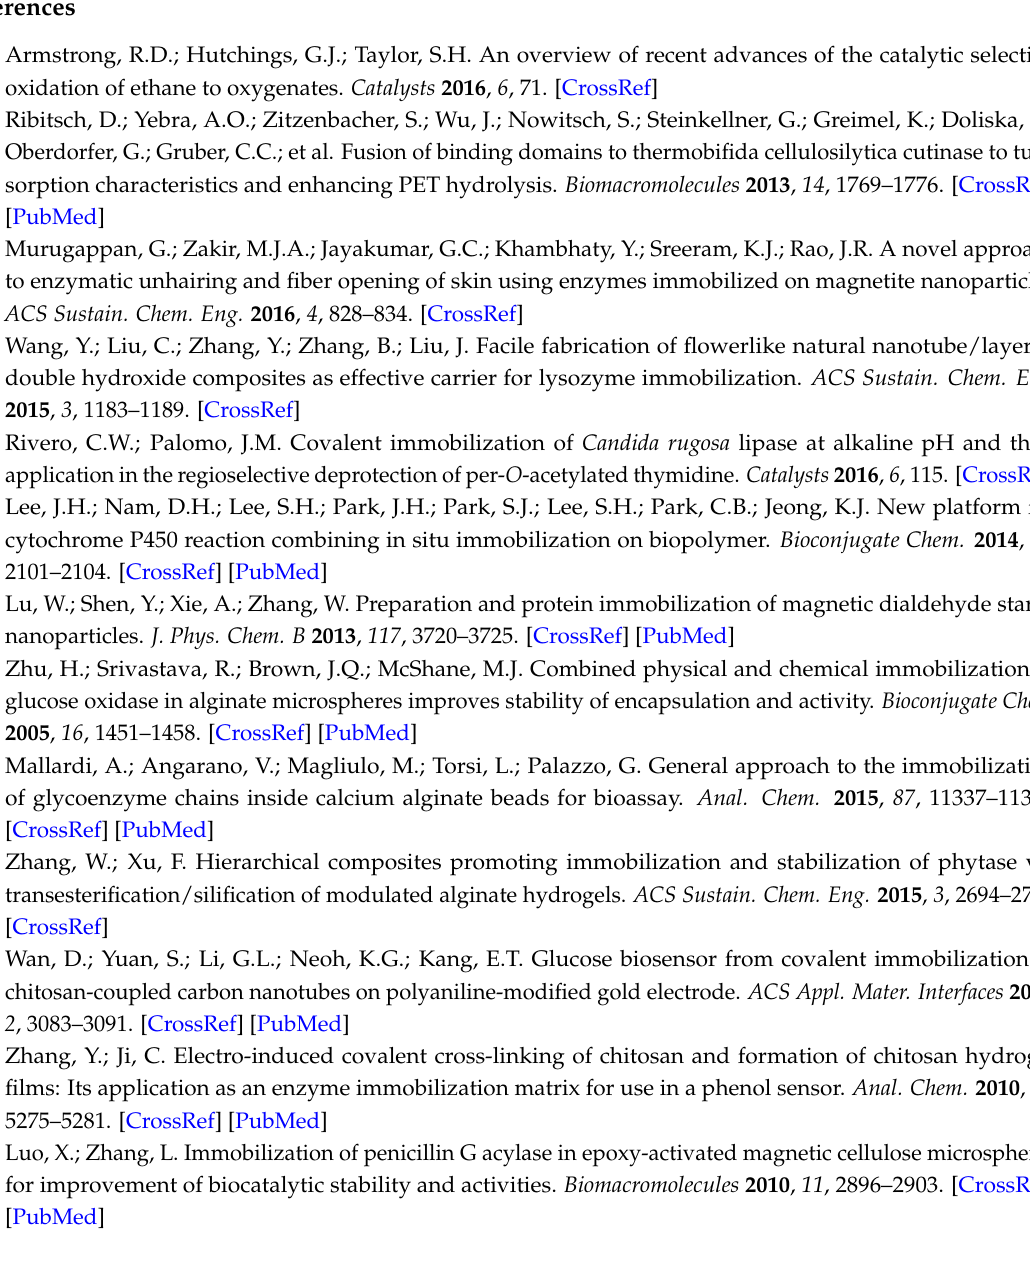
Table S1: ELP monomer, Table S2: The gene of the heme-dependent peroxidase, Figure S1: Plot of the initial rate of reaction ( V 0 ) as a function of the substrate concentration for HDP-ELP, Figure S2: Effect of temperature and pH conditions on the enzymatic activity for